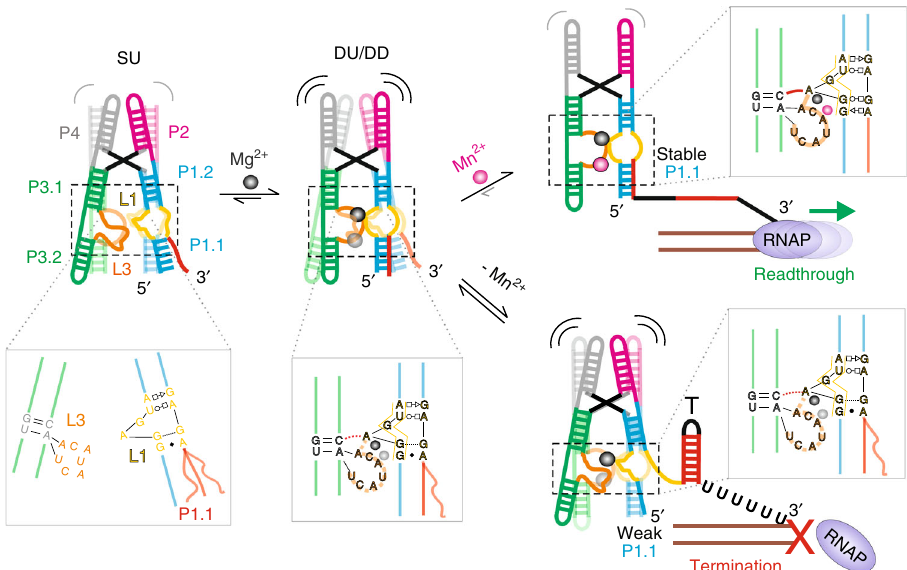
Fig. 8 Local-to-global signal transduction pathway in the core of the Xory Mn 2 + sensing riboswitch. The Xory riboswitch exists in an “ X-shaped ” extended SU conformation in the absence of Mg 2 + , with very rare transitions into docked “ H-shaped ” conformations. In the SU state, the legs are far apart in the absence of a stable A-minor tertiary interaction and loops L3 and L1 are less structured under these conditions. In the presence of physiological Mg 2 + concentrations (mM), the riboswitch samples docked conformations with distinct kinetics, indicative of differences in L3 stacking as observed in our crystal structures. L1 adopts an S-turn conformation (as indicated by the yellow box in the inset) and L3 is partially stacked under these conditions, aided by the presence of Mg 2 + ions in M A,Mg and transiently in M B,Mn . In the presence of suf fi cient Mn 2 + , binding of the metal ion by A48 reinforces L3 stacking and stability of the A-minor interaction. This maintains L1 in a rigid noncanonical SRL-like conformation that enables co-axial stacking between P1.2 and the switch helix P1.1. In turn, this cascade of interactions stabilizes P1.1, thereby preventing strand invasion to favor formation of the antiterminator required for transcriptional